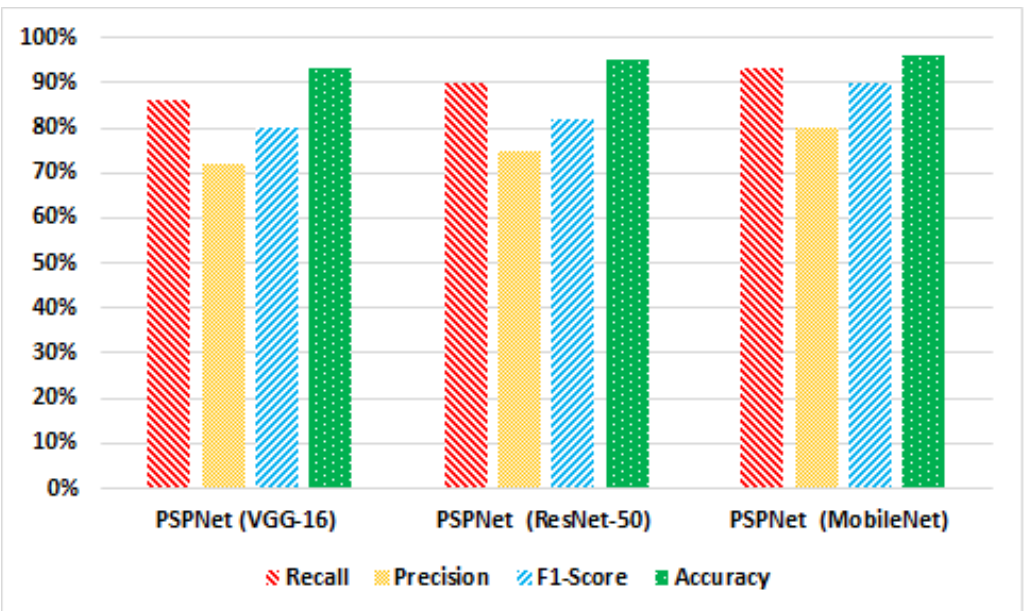
Figure 10. Evaluation results with different classification